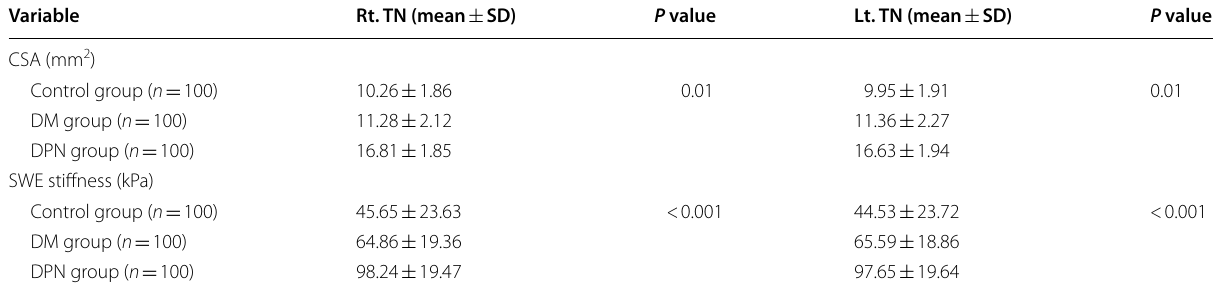
Table 2 Bilateral Tibial nerve CSA and mean nerve stiffness value by ultrasound elastography among controls, diabetes mellitus and diabetic peripheral neuropathy